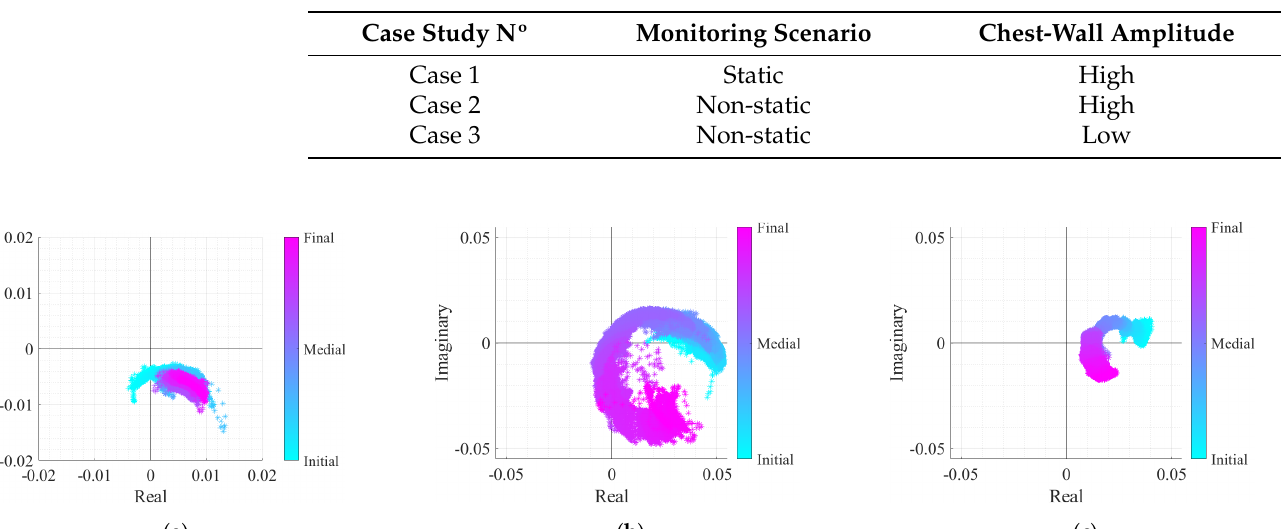
Table 1. Case studies description.